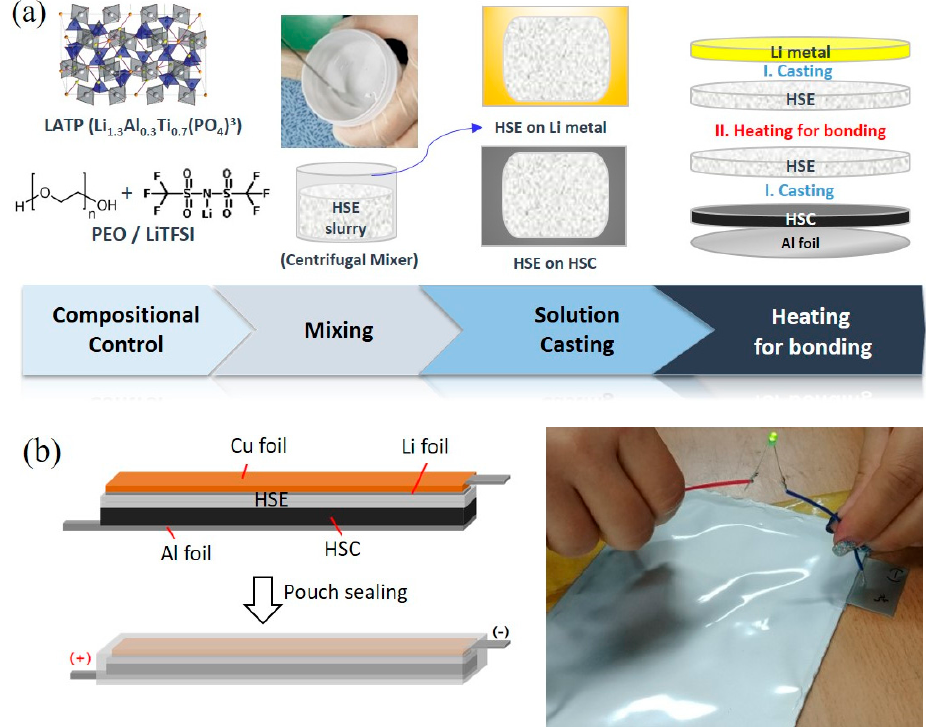
Figure 1. ( a ) Preparation of all ‐ solid ‐ state coin ‐ cell using the designed HSE and HSC in this study. ( b ) Configuration of all ‐ solid ‐ state pouch cell at a 5 × 10 cm 2 scale ( left scheme) and its operation ( right picture).